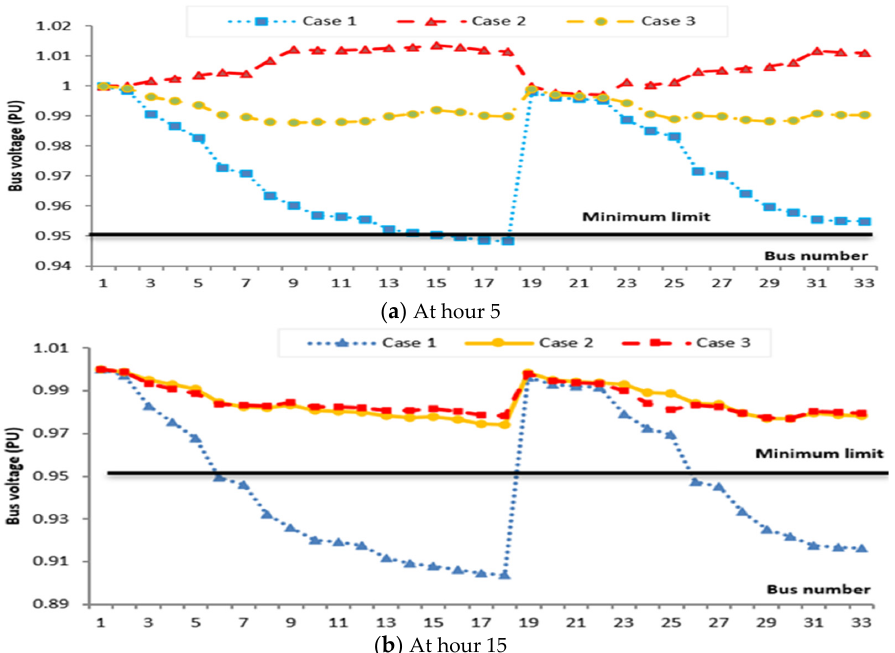
Figure 14. Voltage profile for the first MG at light and peak loading at hours 5 and 15, respectively.